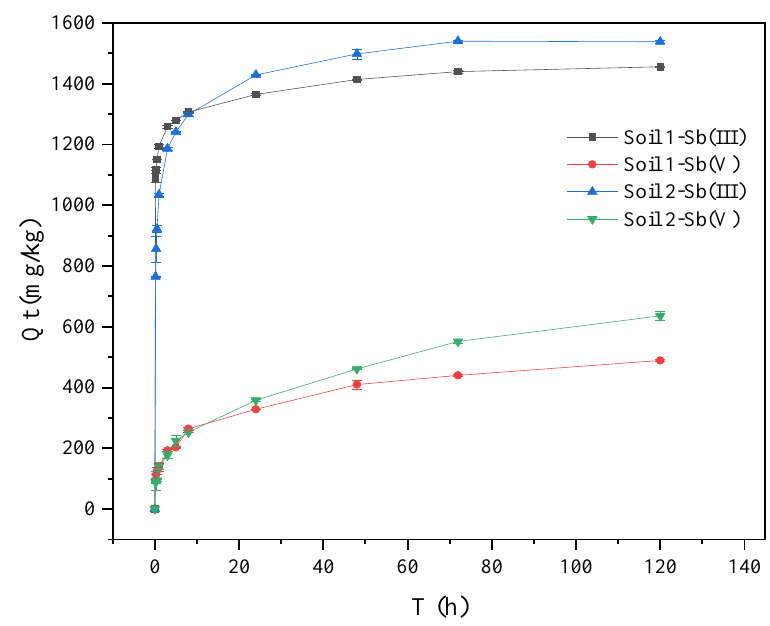
Figure 1. Variation of Sb adsorption on soils with time.